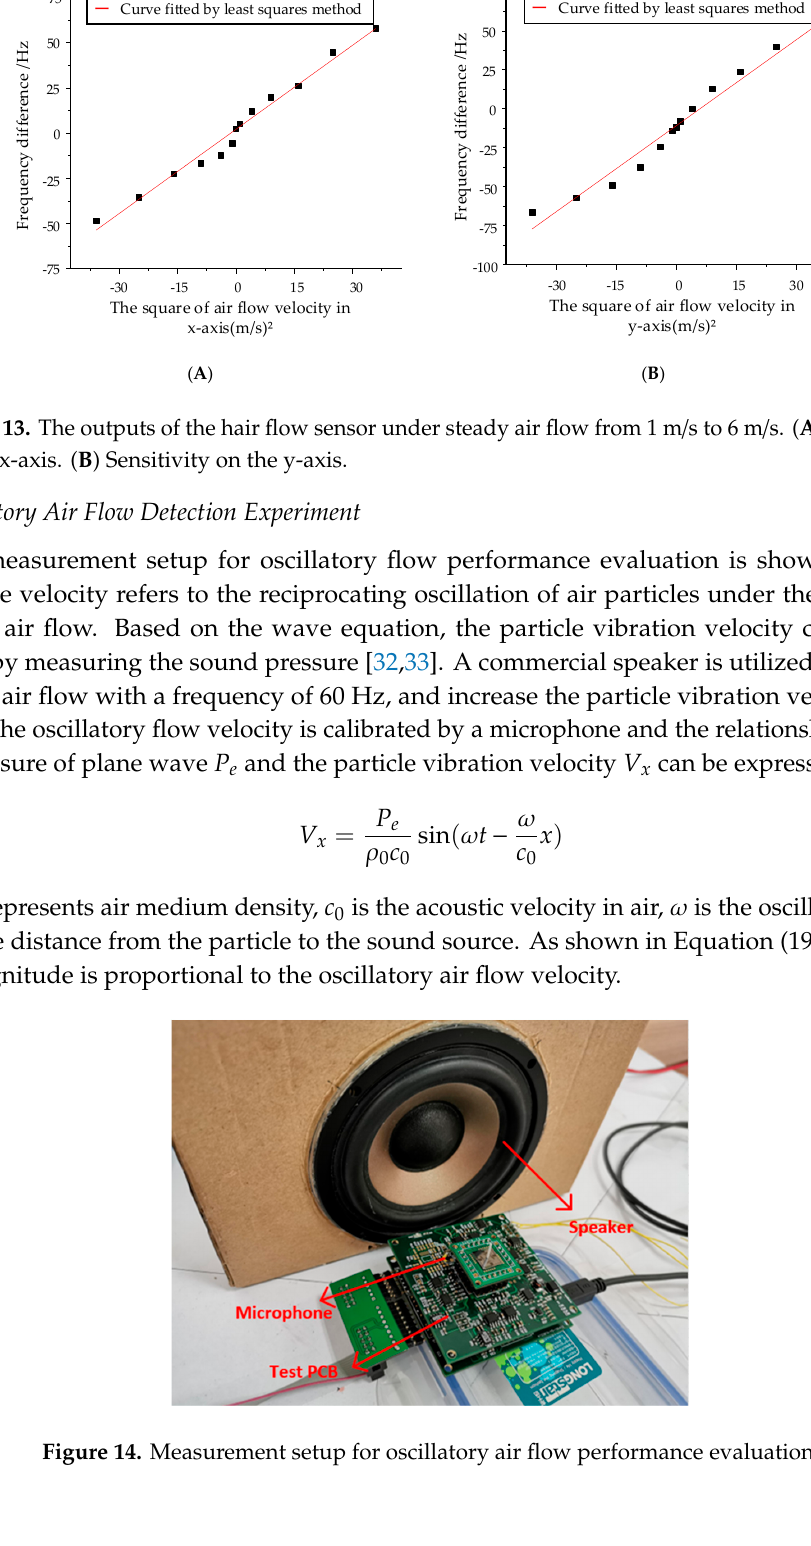
Figure 14. Measurement setup for oscillatory air flow performance